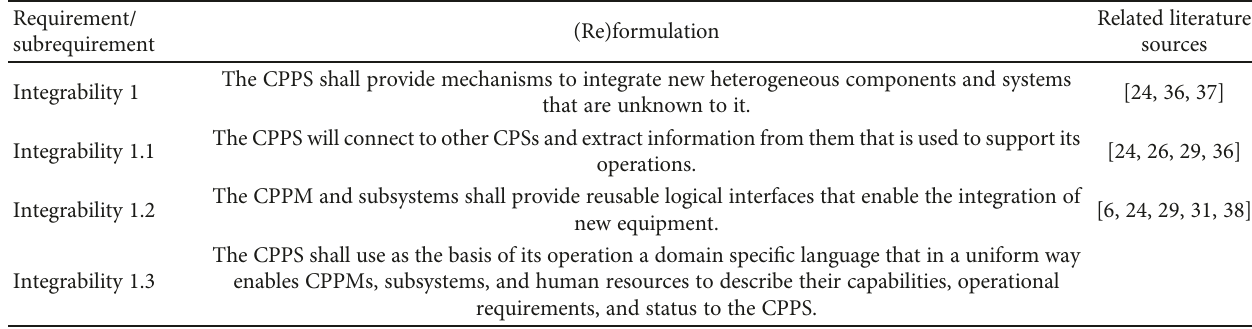
Table 3: Synthesis and reformulation of requirements on